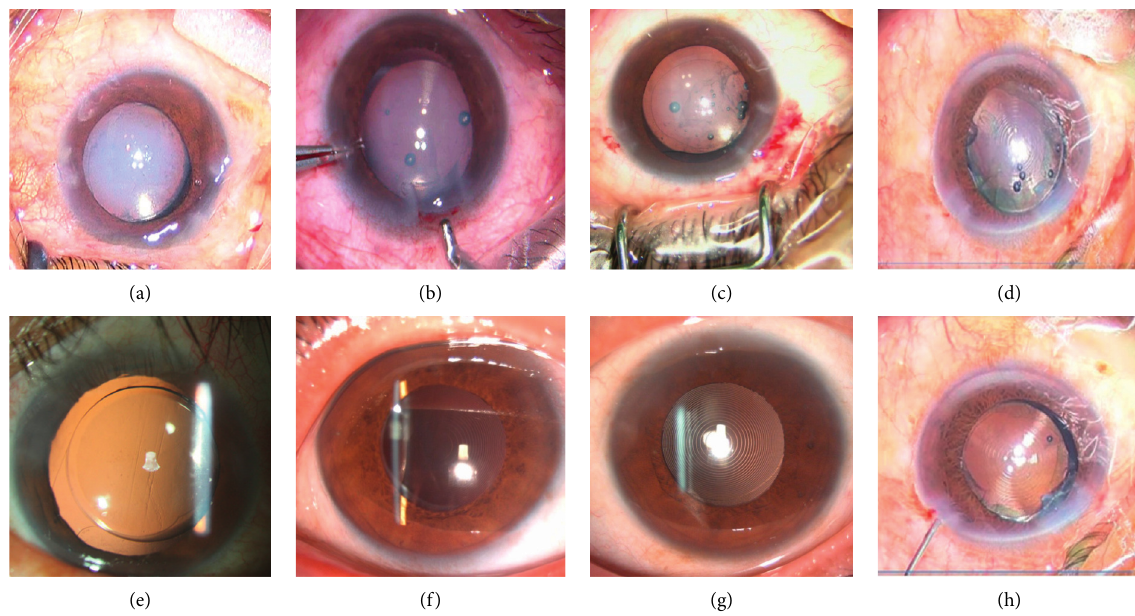
Figure 3: Intraoperative IOL opacity. (a)–(d) The clouding of the optical region immediately after IOL implantation. (e)–(g) The transparent IOL at 1 day after surgery. (h) No opacification after irrigation.